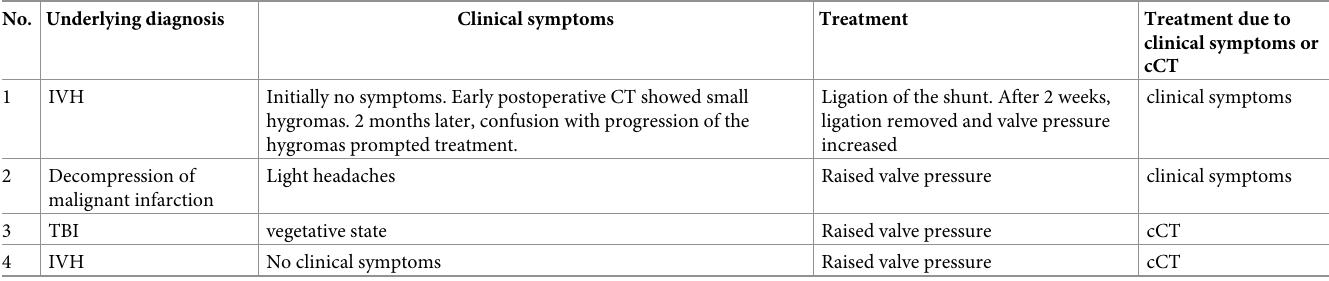
Table 2. Data of patients with hygromas due to VP shunt overdrainage.